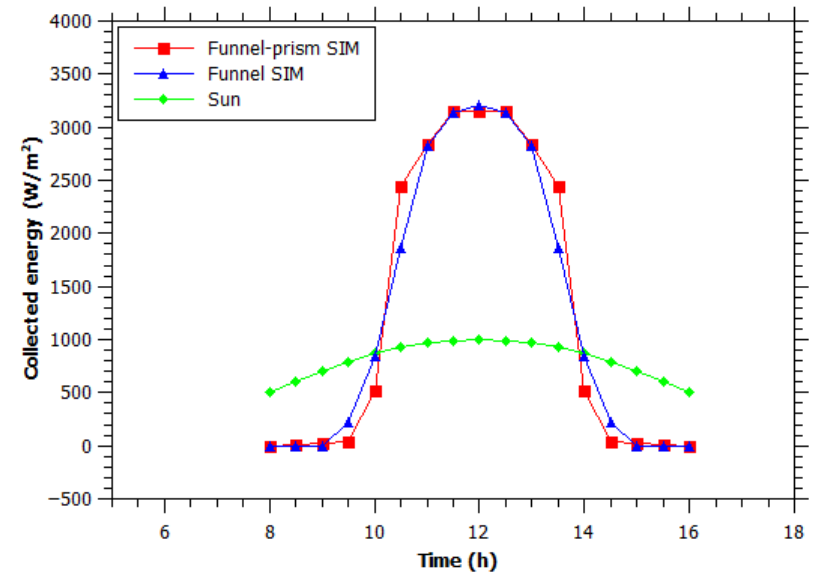
Figure 3. Collected energy as obtained with ray-tracing